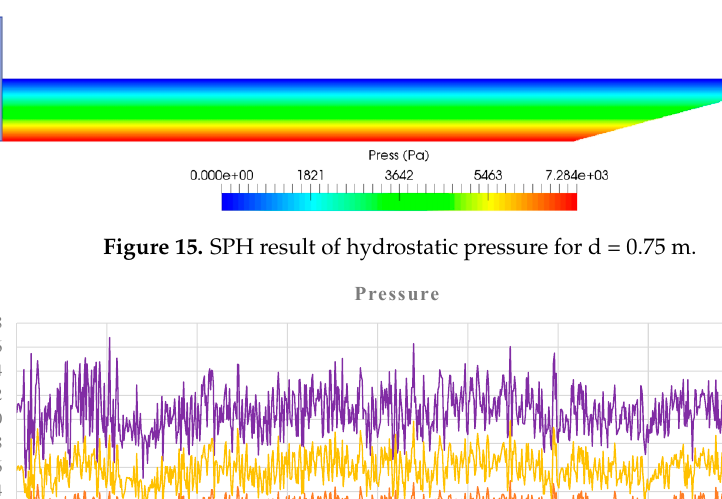
Figure 14. Visual comparison of wave-surface deformation at t = 35.0 s, 35.2 s, 35.4 s, 35.6 s.